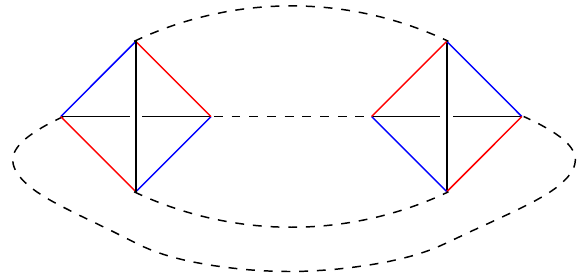
Figure 8 . The fundamental melon for the CTKT model in the tetrahedron representation. Dashed edges represent